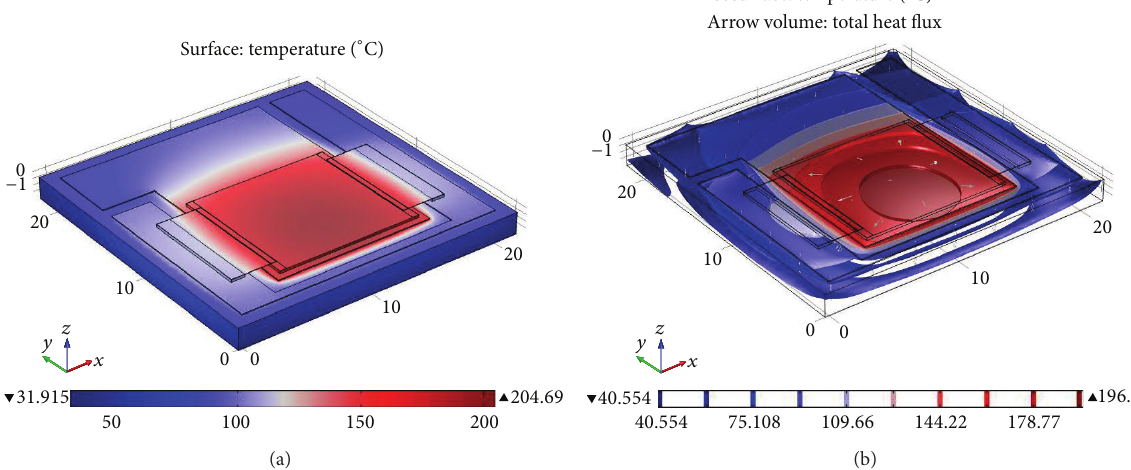
Figure 4: Temperature distribution (a) and isothermal contours (b) in the PCB based assembly, in ∘ C. Max cell’s temperature: 204.7 ∘